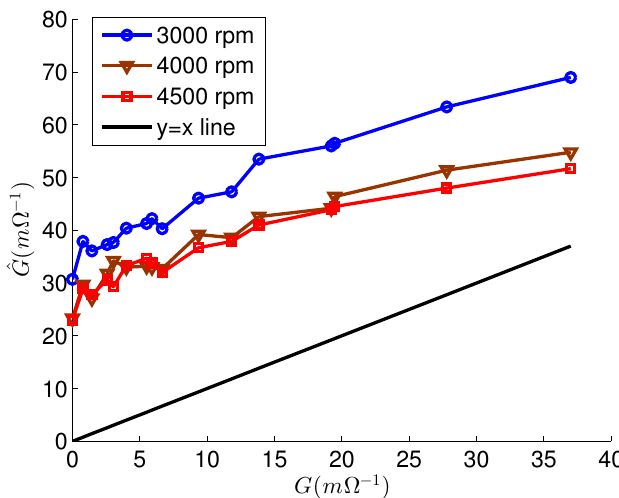
Figure 10. The estimation result ˆ G without L